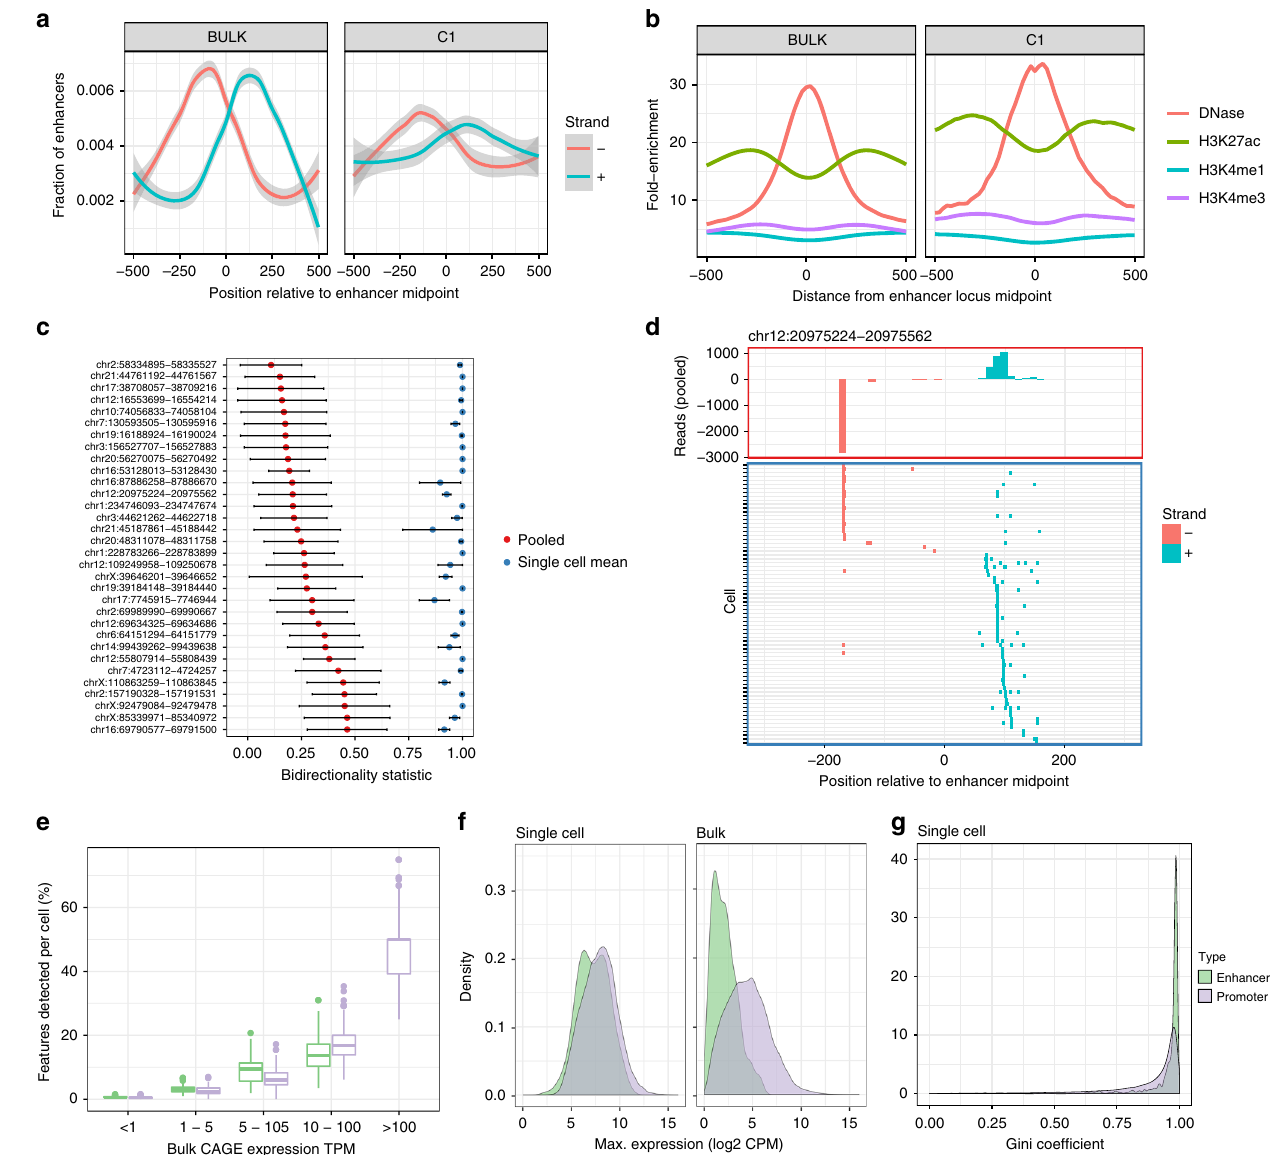
Fig. 4 Enhancer analysis at single-cell resolution. Comparison of enhancers detected by bulk CAGE and pooled C1 CAGE data a showing bidirectional read pro fi les smoothed by generalized additive model and b epigenetic pro fi les. c Bidirectionality scores (0: equally bidirectional; 1: fully unidirectional) at selected enhancers for pooled cells downsampled to the same depth as corresponding single cells 100 times (red dots: mean, black bars: standard error) and single-cells (blue dots: mean; black bars: standard error). d Example locus on chromosome 12: read pro fi le histogram (upper box), and read presence or absence in single-cells (lower box). e – g Comparison of enhancers and gene promoters in C1 CAGE and bulk CAGE: e fraction of bulk features detected within each cell, strati fi ed by bulk expression level, centre line = median, box = 25th to 75th percentiles, whiskers = up to 1.5× interquartile range from the box. f Density plots of the maximum expression levels, g Gini coef fi cient distribution in single-cell data. Lower scores: broad expression (expressed in more cells); higher scores: more speci fi c/enriched expression (fewer cells). Source data are provided as a Source Data fi